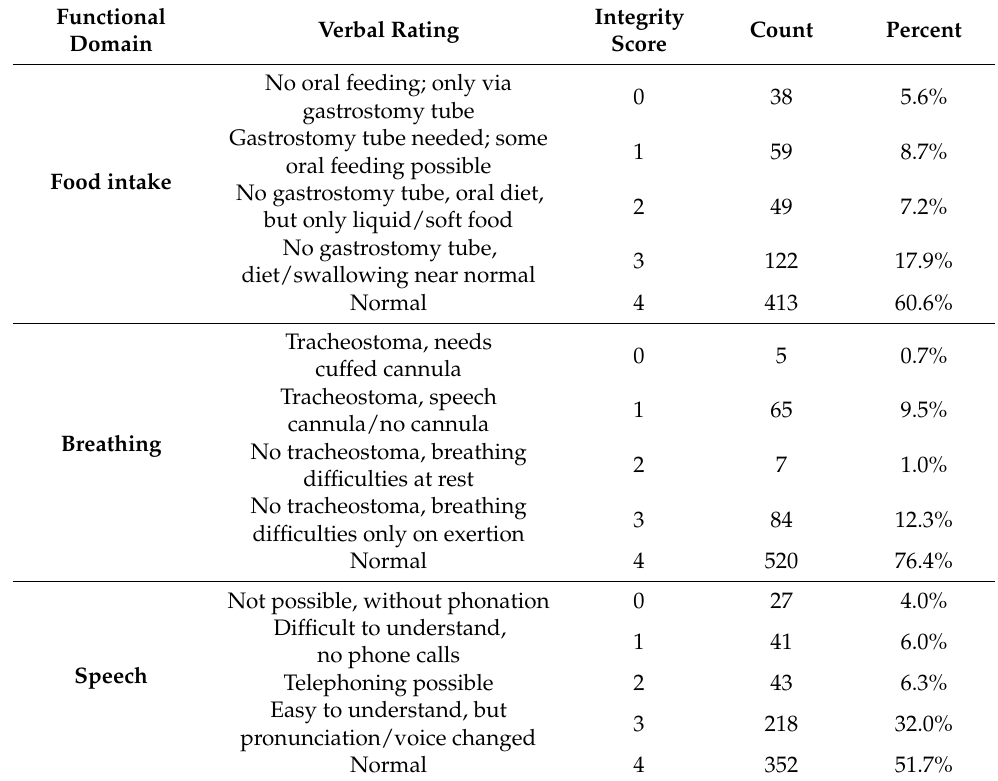
Table 1. Absolute & relative frequencies (percent) of functional outcomes of 681 HNC-survivors at a median of 4 years after initial diagnosis. The number of patients per functional domain and level as well as the relative proportion in percent are